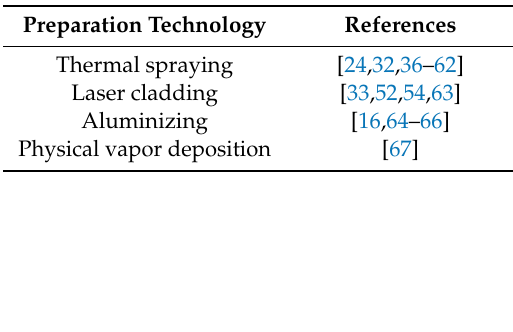
Table 3. List of preparation technology used by di ff erent authors in the biomass / co-fired